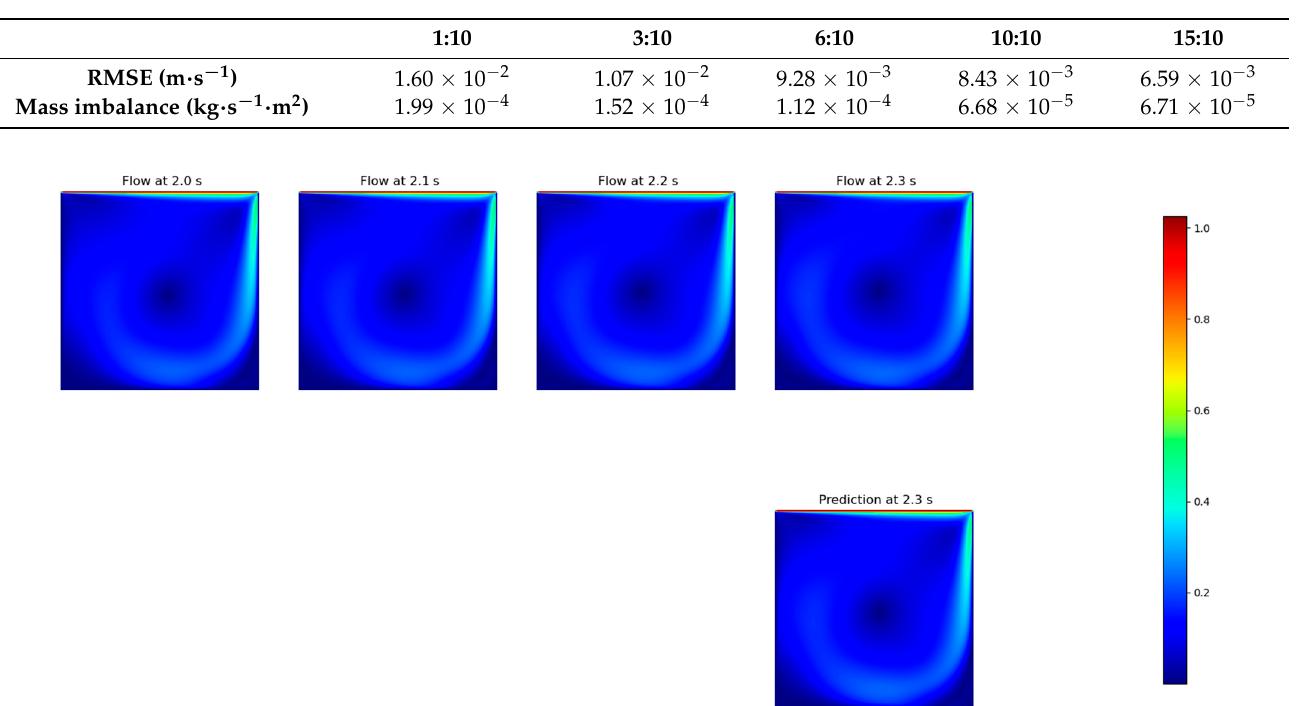
Table 6. FNO testing errors for predicting several timesteps in advance, for three input time window sizes, after a maximum of 300 epochs.